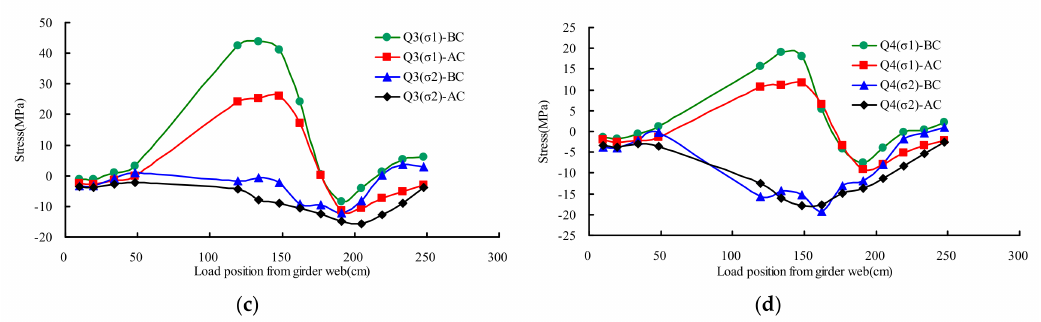
Figure 11. Principal stresses of rib-to-diaphragm under transverse wheel positions: ( a ) Q1; ( b ) Q2; ( c ) Q3; ( d ) Q4.